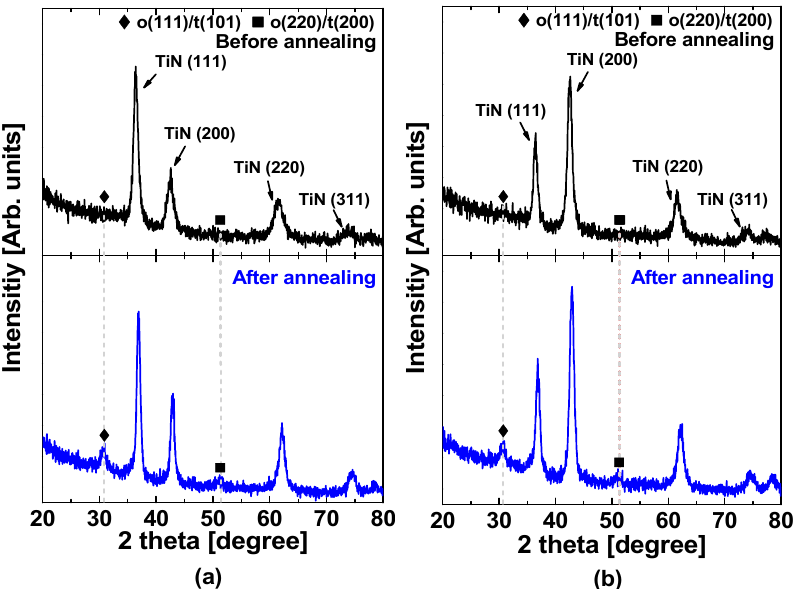
Figure 4. GIXRD patterns measured before and after the RTA process for TiN/undoped HfO 2 /TiN samples with both top and bottom TiN electrodes deposited at ( a ) room temperature and ( b ) 250 ◦